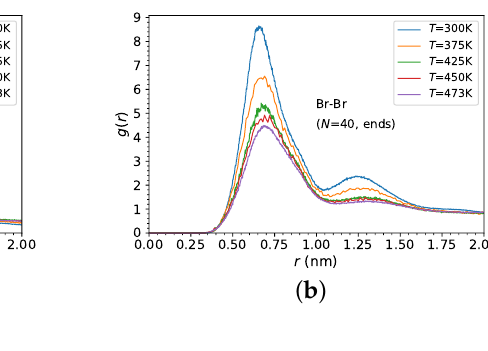
Figure 3. Br − -N + radial distribution functions g Br,N ( r ) of ( a , b ) end-functionalized PDMS chains, ( c , d ) f = 10% randomly grafted functionalized PDMS chains, at different temperatures. ( a , c ) N = 80 versus ( b , d ) N = 40 and ( e , f ) for various charged monomer fractions at ( e ) T = 300 K, ( f ) T = 473 K.